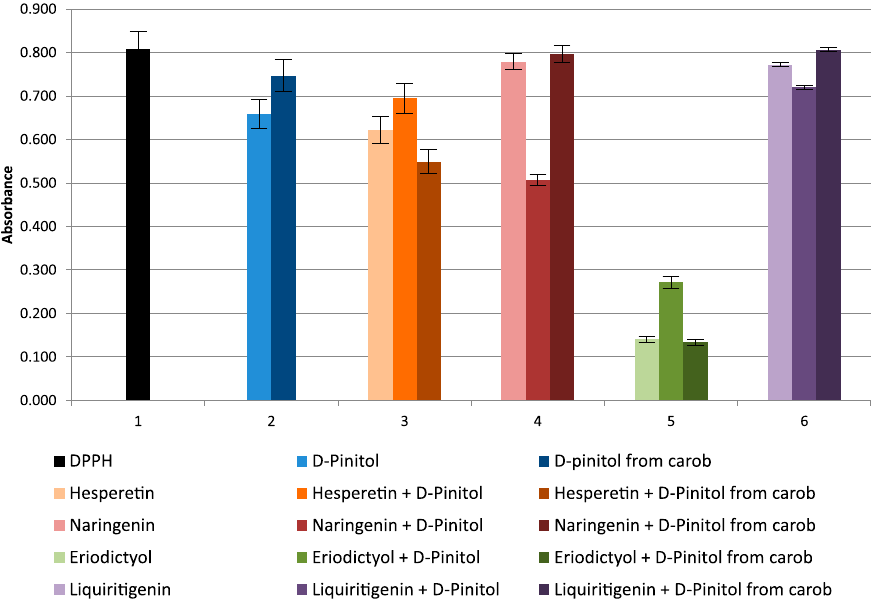
Figure 3. Changes in absorbance of D -pinitol (standard 11.7 mg/mL), D -pinitol from carob (11.7 mg/mL), flavanones (hesperetin, naringenin 16.7 µ g/mL; liquiritigenin 20 µ g/mL; eriodictyol 6.7 µ g/mL), and mixtures of flavanones with cyclitols.